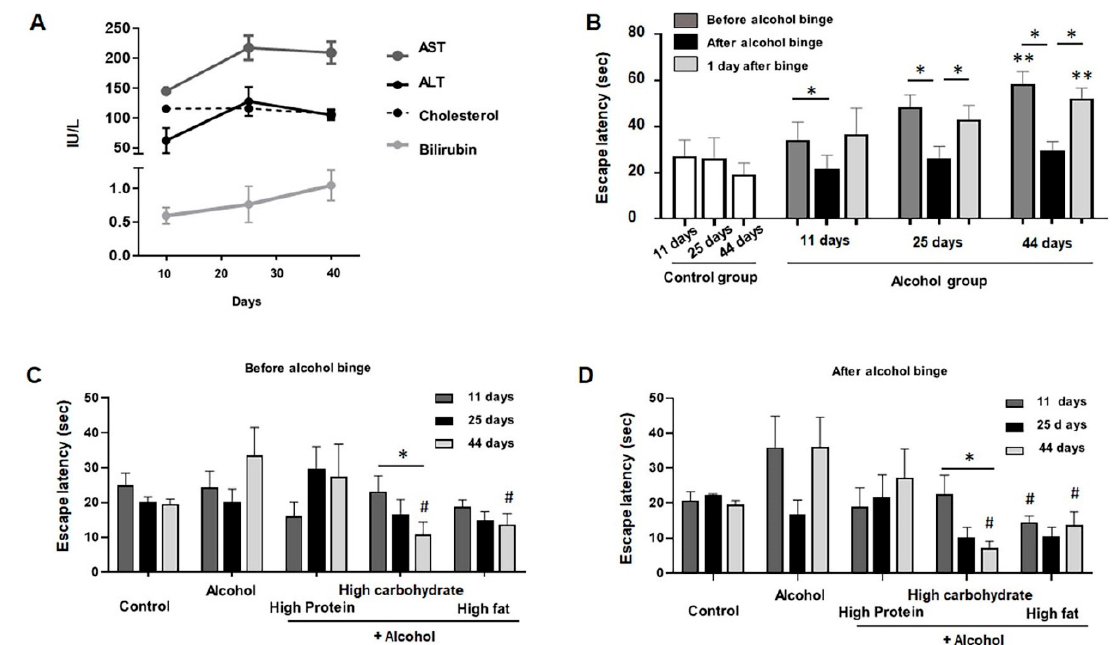
Figure 3. Liver enzyme and T-maze test. ( A ). The serum level of liver enzyme in alcohol group mice ( n = 20). ( B ). Change of T-maze test in alcohol mice ( n = 20). ( C ). T-MAZE before alcohol binge. ( D ). T-MAZE after alcohol binge. The data are presented as the mean ± standard error of the mean (SEM) and were statistically analyzed using a one-way ANOVA (LSD) and Mann–Whitney test. * p < 0.05 difference at the posthoc test (LSD); ** p < 0.05 difference between the three groups (11 days, 25 days, and 44 days); # p < 0.05 difference compared with alcohol group. AST, (Aspartate aminotransferase); ALT,